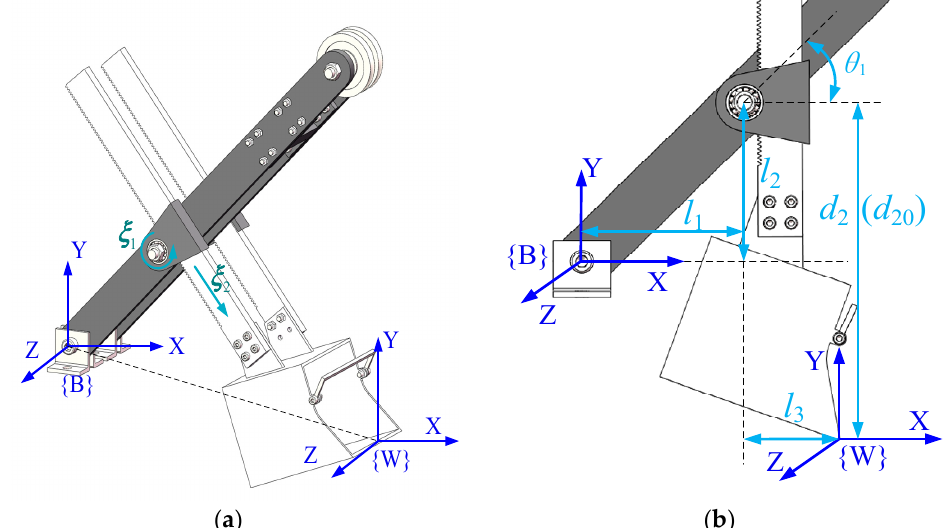
Figure 3. Establishment of the coordinate system of the scale model: ( a ) general posture; ( b ) initial posture ( l 1 , l 2 –horizontal and vertical distance from the saddle rotation center to the origin of co- ordinate system {B}; l 3 –the distance from the saddle rotation center to dipper tooth tip in vertical direction of the dipper handle; θ 1 –the dipper handle rotation angle; d 2 –the dipper handle elongation; 𝑑 20 –initial value of the dipper handle elongation).